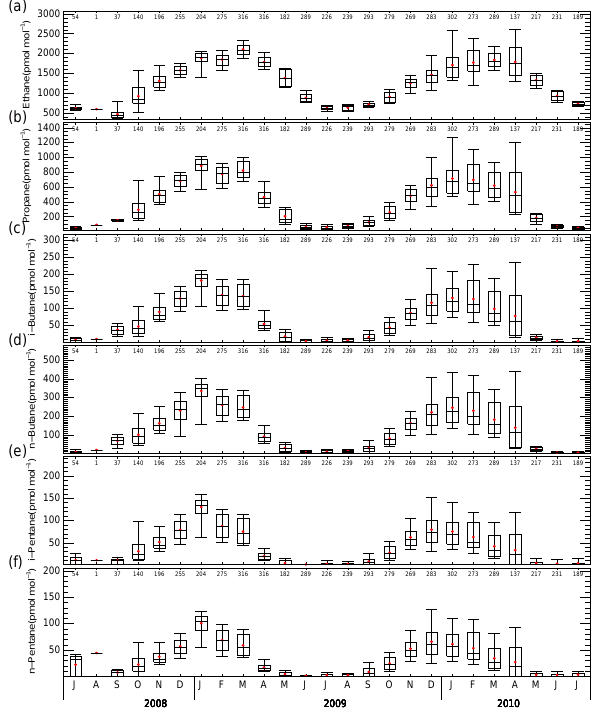
Figure 5. Monthly averages of (a) ethane, (b) propane, (c) , i -butane, (d) n -butane, (e) i -pentane, and (f) n -pentane, at Summit during from July 2008 to July 2010. Median and mean are indicated by a horizontal line and black square, respectively; the box indicates the middle 67% of the data; and the vertical whiskers indicate the 5th and 95th percentile of all the data. The numbers at the top of each plot represent the number of measurements included in the